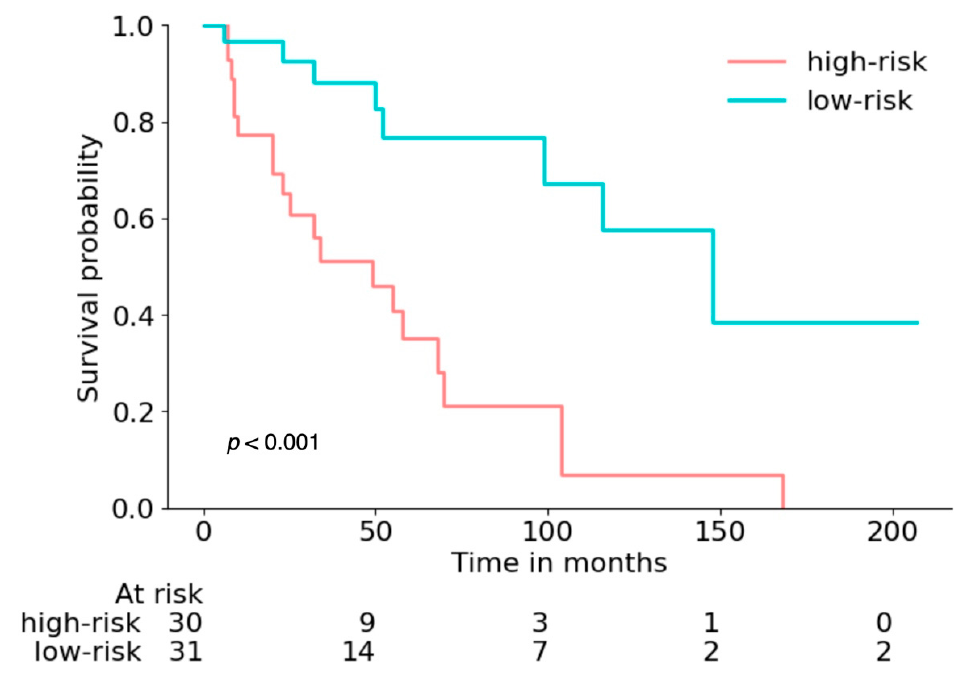
Figure 4. Kaplan–Meyer analysis for the combined model dichotomized into high- and low-risk groups according to the median predicted risk score from the training dataset, evaluated in the test dataset. The log-rank test was used to compare risk groups. The number of subjects at risk is provided below the graph.